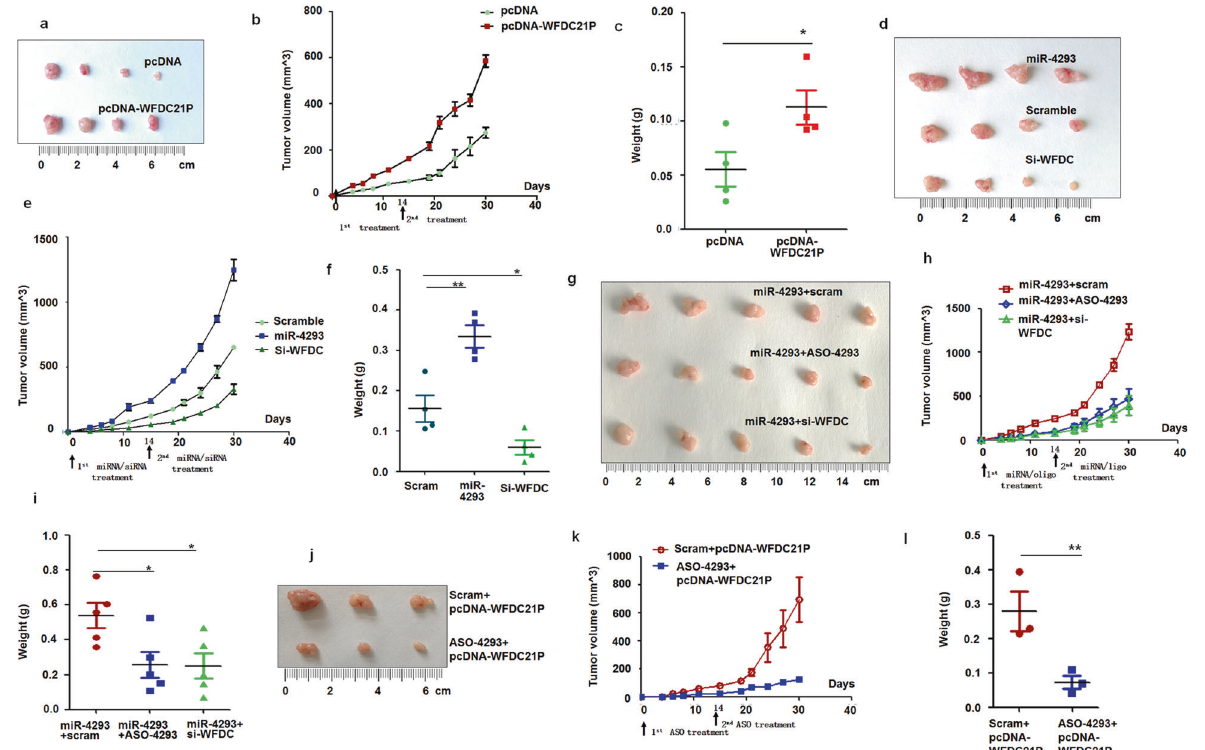
Fig. 6 miR-4293 and WFDC21P promote tumorigenesis in vivo. miR-4293 transfection elevated miR-4293 level, which could be reduced by ASO. pcDNA-WFDC21P increased WFDC21P and Si-WFDC treatment reduced WFDC21P level. a – c Analysis of xenograft of A549 cells treated with pc-DNA or pcDNA-WFDC21P ( n = 4). Quantitative analysis of tumor volume ( b ) and tumor weight ( c ) of xenografts. The xenografts of each group were weighed and data were expressed as median (interquartile range). * p <0.05; Mann-Whitney U t -test. d – f Analysis of xenograft tumors of miR-4293-, si- WFDC-, and scramble-treated A549 cells ( n = 4). Quantitative analysis of tumor volume ( e ) and tumor weight ( f ) of xenografts. Data are expressed as median (interquartile range). ** p <0.01, * p <0.05; Kruskal-Wallis H test. g – i Analysis of xenograft tumors of miR-4293-, miR-4293 + ASO-4293- and